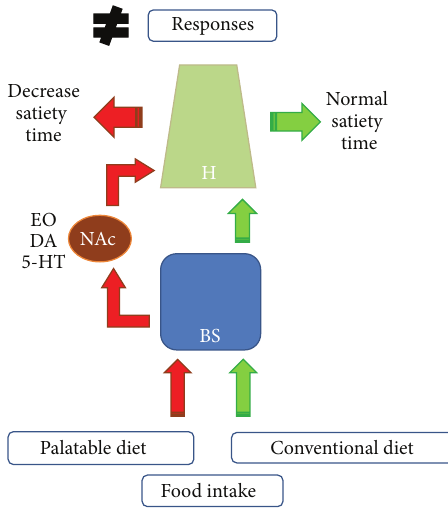
Figure 2: Signaling of food intake in the brain. The signaling pathway activated by a conventional diet is shown on the right (green), whereas the signaling induced by a palatable diet is shown on the left (red). H: hypothalamus; NAc: nucleus accumbens; BS: brain stem. EO: endogenous opioids; DA: dopamine; 5-HT: